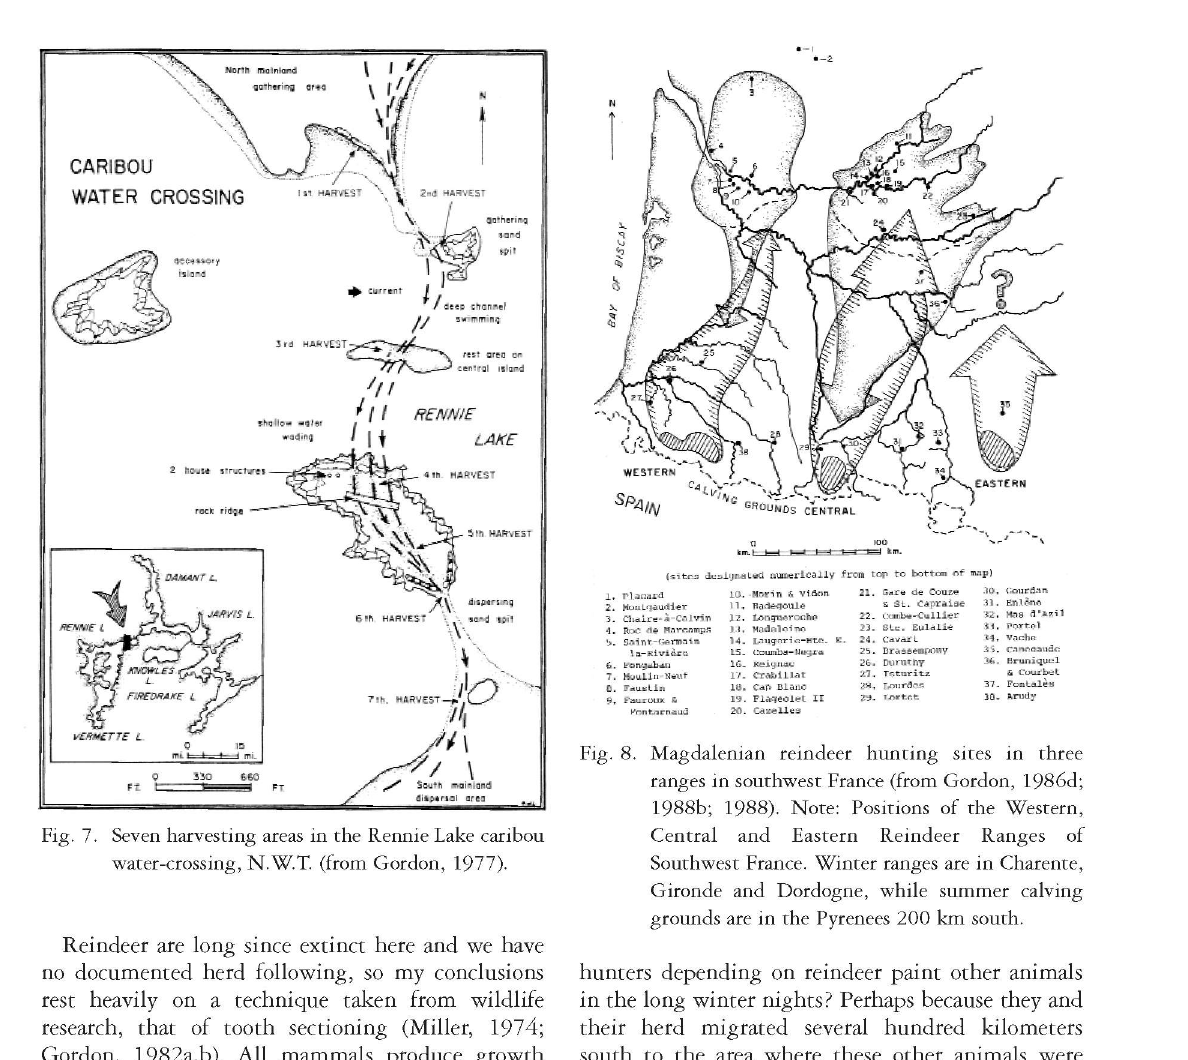
Fig. 8. Magdalenian reindeer hunting sites in three ranges in southwest France (from Gordon, 1986d; 1988b; 1988). Note: Positions of the Western, Central and Eastern Reindeer Ranges of Southwest France. Winter ranges are in Charente, Gironde and Dordogne, while summer calving grounds are in the Pyrenees 200 km